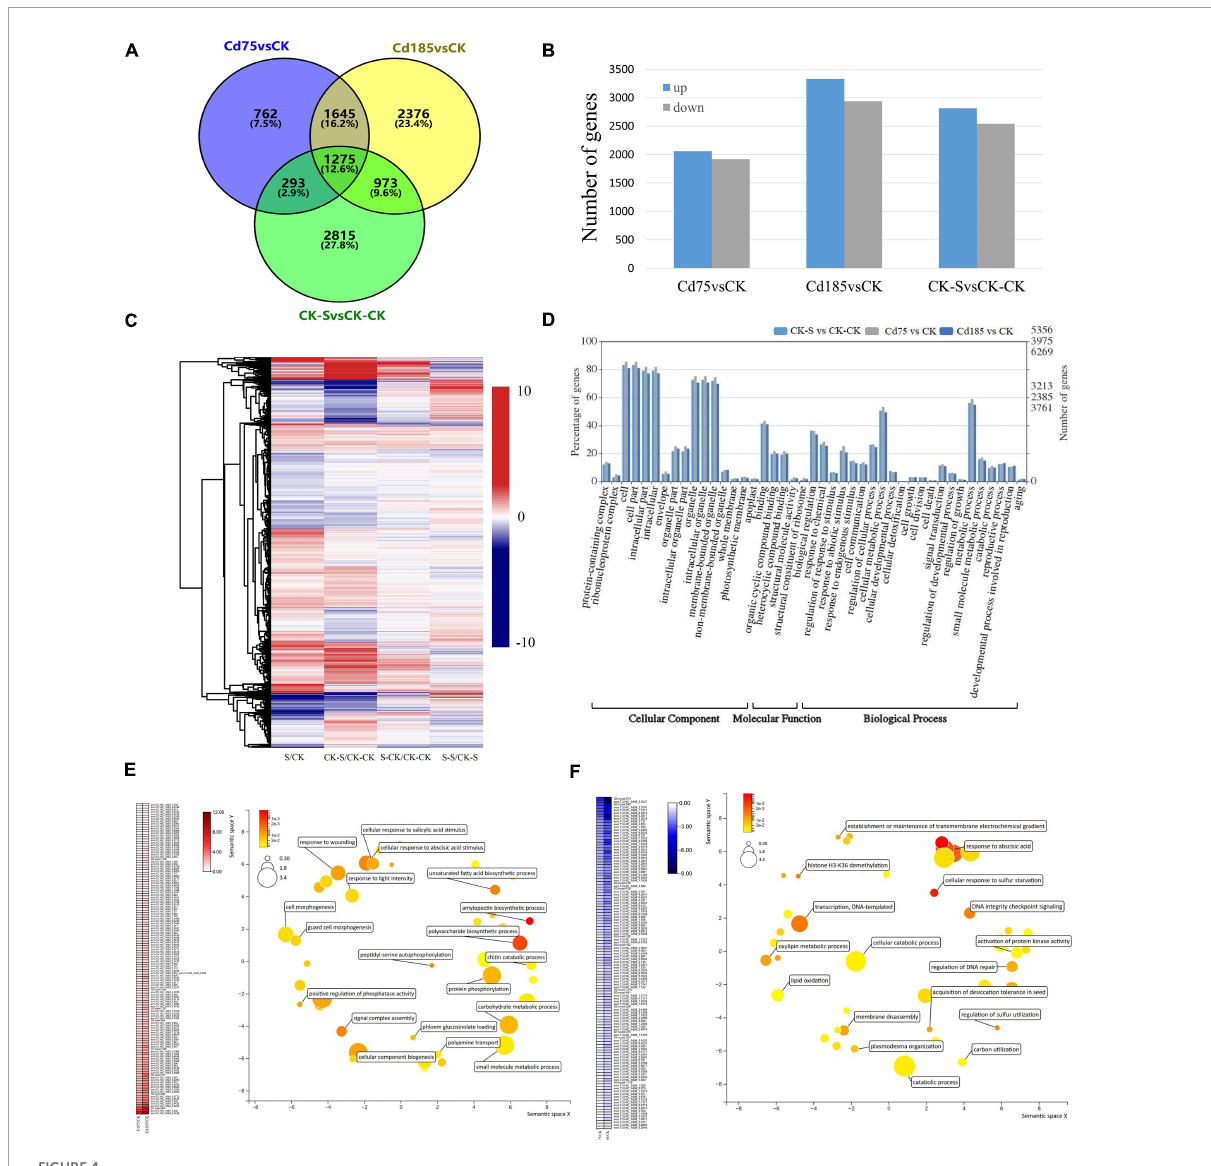
FIGURE4 Expression and function of Cd-responsive genes. (A) Comparison and distribution of Cd-responsive genes in G1 (Cd75, Cd185) and G2 (CK-S) using CK (G1) and CK-CK (G2) as controls. (B) Numbers of upregulated and downregulated genes. (C) Differential expression patterns of Cd-responsive genes. The color represents log 2 fold change values; negative values (blue) represent downregulation and positive values (red) represent upregulation. (D) Gene Ontology (GO) classifications of the DEGs. (E,F) Expression and biological processes of genes with enhanced upregulation (E) or downregulation (F) along with the increase of soil Cd concentration in G1. For the heatmap, color was adjusted to log 2 fold change of comparison pairs. For GO map results, the color and size were adjusted to p -value and log 10 p -value,